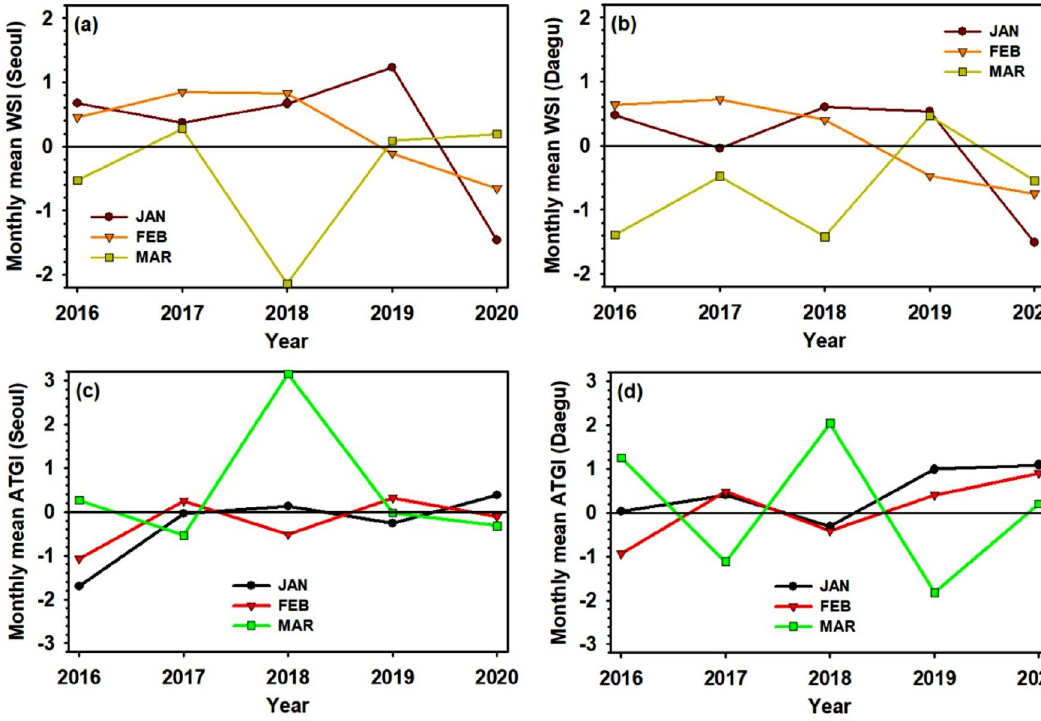
Figure 4. January, February, and March mean wind speed index (WSI) in ( a ) Seoul and ( b ) Daegu, and air temperature gradient index (ATGI) in ( c ) Seoul and ( d ) Daegu from 2016 to